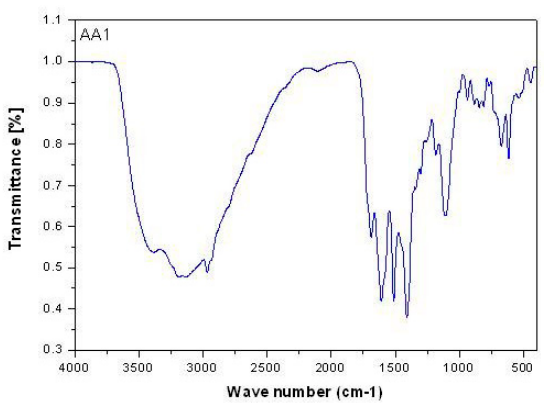
Figure 2. Infrared spectrum of NH 4 [(VO)(FA)(AA 1 )] complex (where AA 1 = isoleucine).